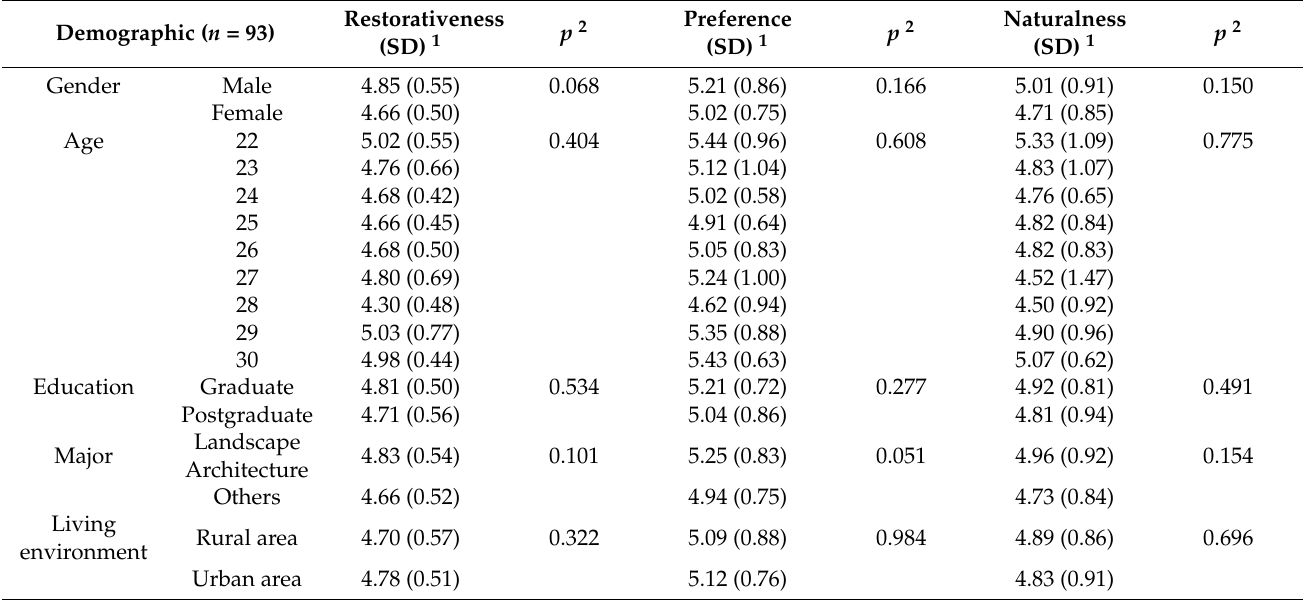
Table 5. Demographic characteristics, aesthetic preference, restoration potential, and perceived